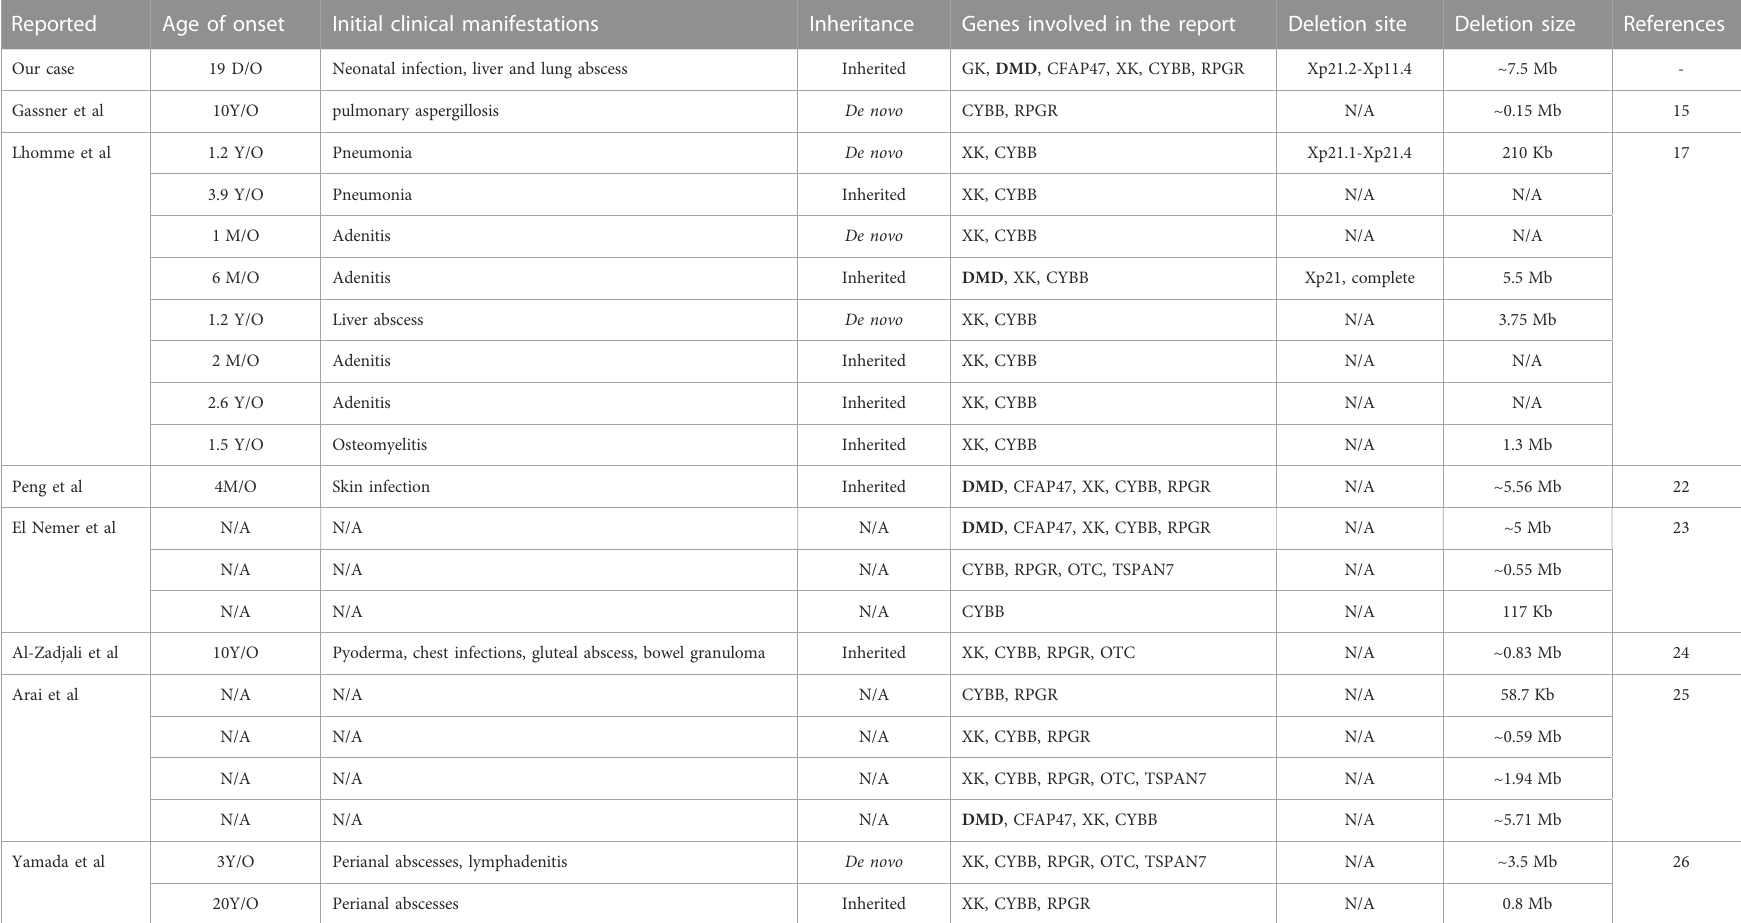
TABLE 1 Age of onset, initial clinical manifestation, and genetic information of reported